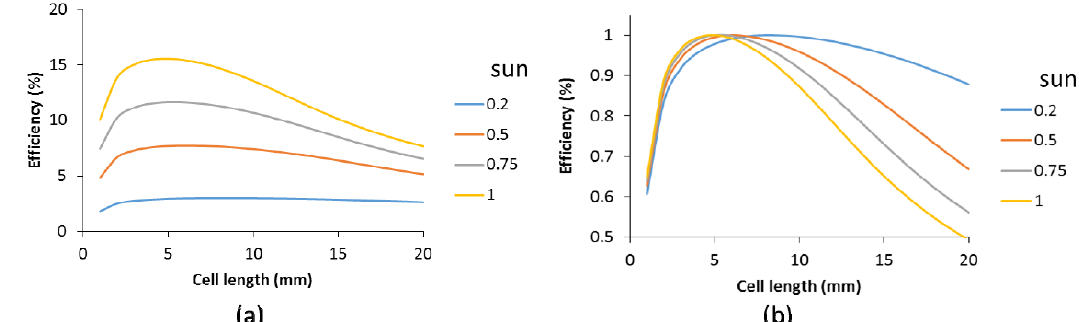
Figure 12. Efficiency as function of the cell length for different light intensities (see legend in sun units, whereby one sun is 1000 W/m 2 ): ( a ) calculated values; ( b ) normalized values.